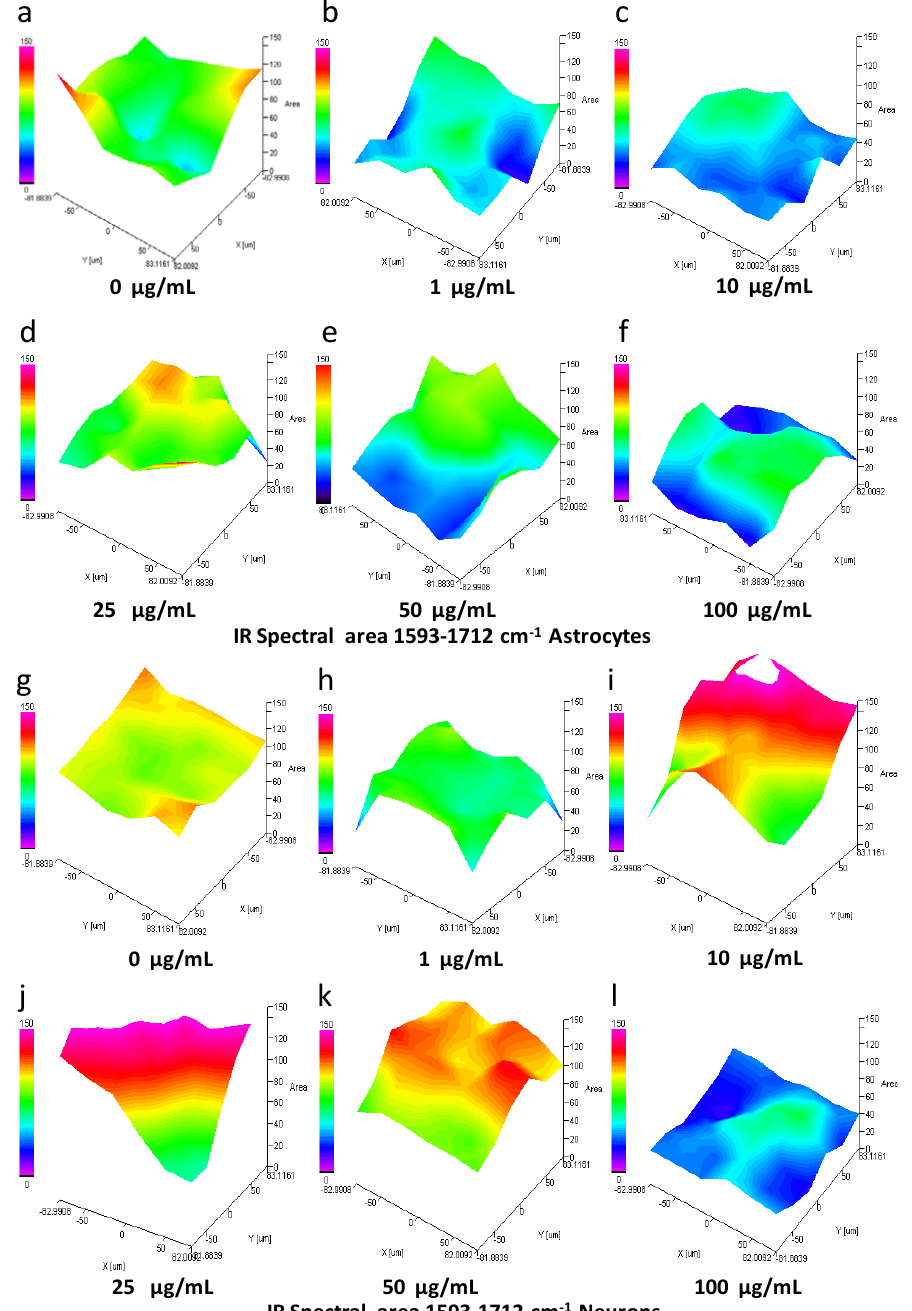
Figure 6. Spectral area analysis by IQ mapping of 1593–1712 cm − 1 region of astrocytes and neurons exposed to SiO 2 -NPs. The spectral region of 1593–1712 cm − 1 that includes specific spectral bands related to secondary structures of proteins is presented for astrocytes ( a – f ) and neurons ( g – l ). A sample of cells treated with SiO 2 -NPs for 24 h was dispersed on a gold-coated slide. The three-dimensional image is presented in the x, y, and z axes, and the area presented as a gradient of color indicates a decrease (from blue) or increase (red) in the spectral signal. In astrocytes, a decrease in the signal seen as a blue area at 1 ( b ), 10 ( c ), 50 ( e ), and 100 ( f ) µ g / mL SiO 2 -NPs is observed compared to control ( a ). No changes were observed at 25 µ g / mL (d). In neurons, a strong increase in the signal (red area) was detected at 10 ( i ), 25 ( k ), and 50 ( l ) µ g / mL. In contrast, at concentration of 1 ( h ) and 100 ( l ) µ g / mL, spectral signal decrease (green and blue area) when compared to control ( g ). The image is representative of four independent experiments with three technical